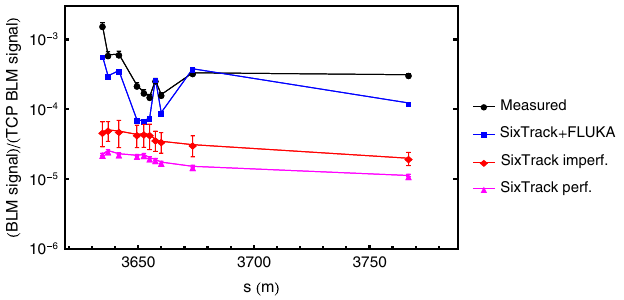
FIG. 13. The ratio of BLM signal, or particles lost, at the BLMs with the highest signal in the IR7 DS, to the signal at the horizontal TCP, in simulations and measurements for the 2011 machine for horizontal losses in B1. The errors on the SixTrack simulations indicate the standard deviation over different random seeds with collimator imperfections. The error bars on the measurements are taken as the standard deviation over the data set.